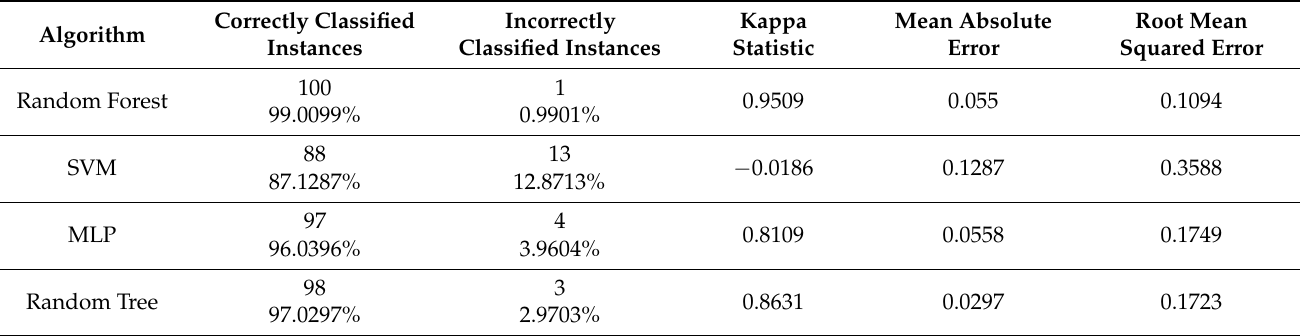
Table 13. Results obtained with different classification algorithms for evaluating the occurrence of diabetic